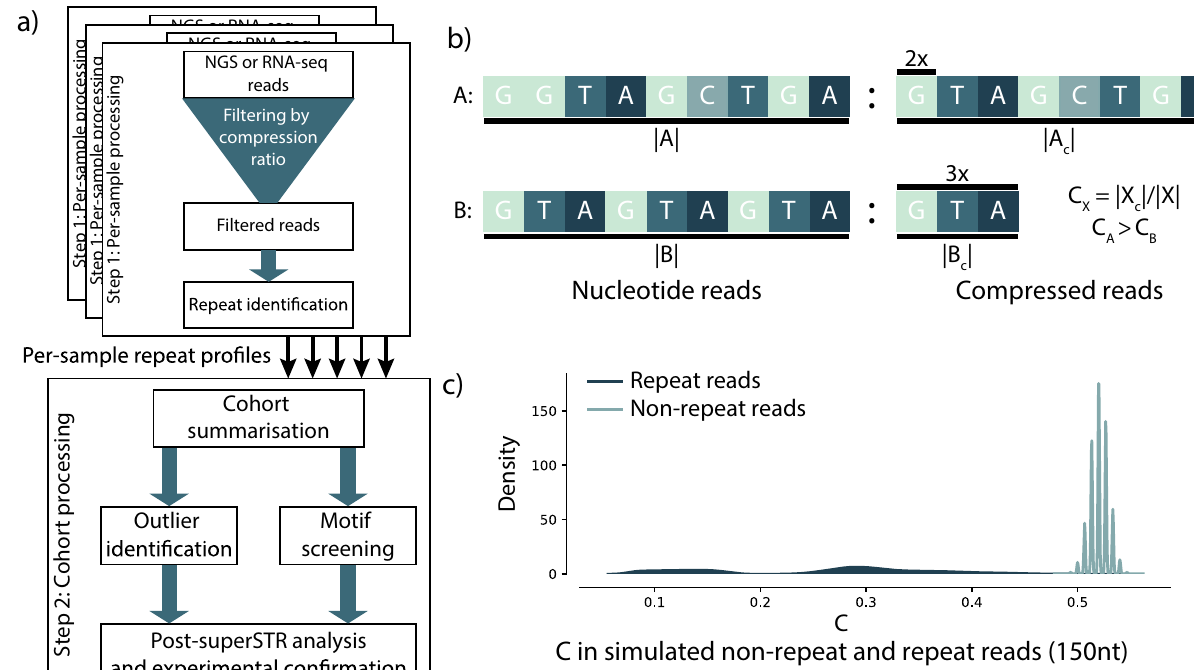
Figure 1. An overview of superSTR, its compression heuristic, and the heuristic’s performance in simulated reads. ( a ) superSTR analysis involves a per-sample processing step where repeats are identified and a cohort- level analysis where samples are analysed, ultimately leading to post-superSTR analysis or experimental confirmation of findings. ( b ) superSTR relies on relative compressibility to distinguish between repeat containing reads. Compression with zlib involves removal of duplication. Read A (which does not contain significant repetition) will compress less than read B (which does), and the ratio of compressed size to uncompressed size will be greater for A than B. B) Distribution of C compression ratios in 150nt pseudorandom reads and repeat-containing reads drawn from a distribution where nucleotides are equiprobable and no errors are present. A more complete characterization across different distributions, read lengths and error rates is contained in Supplementary Figs.